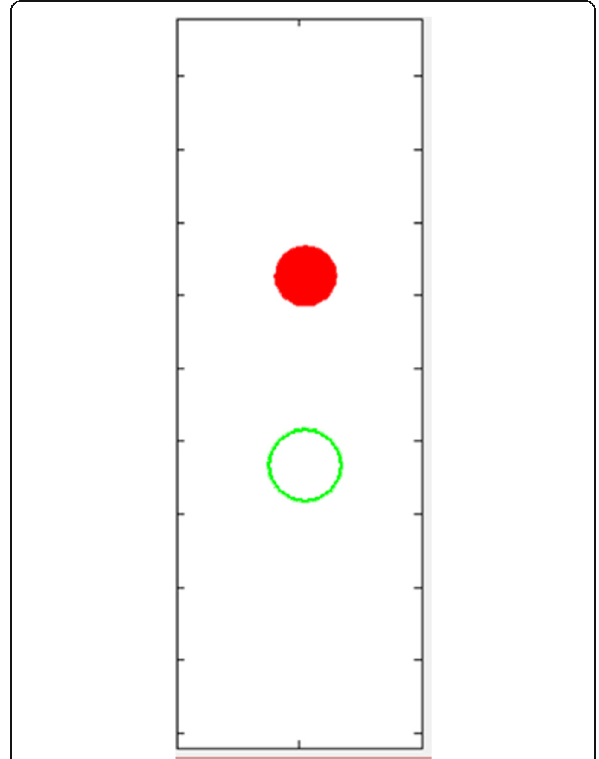
Fig. 4 Screenshot of biofeedback provided to the volunteers. The red circle moves up and down with respiration and the green circle corresponds to the respiratory level, previously